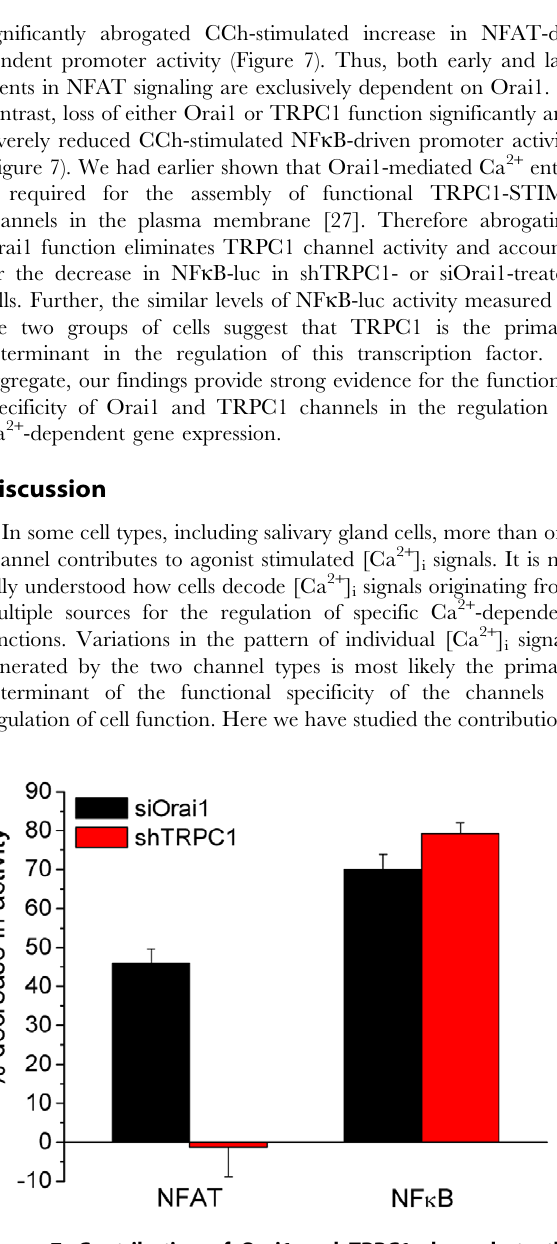
Figure 6. ‘‘All-or-none’’ mode of NFAT activation by Orai1-mediated Ca 2 + entry. [ Ca 2 + ] i responses induced by 300 nM CCh in control cells ( A ), cells expressing STIM1-KK/EE ( B ) or Orai1E106Q ( D ), and cells in Ca 2 + -free media ( C ). Each trace is representative of data obtained from $ 50 cells in at least 3 separate experiments. Insets in A and B show corresponding responses induced by 1 m M CCh over a 10 min time period. ( E ) Average change in the amplitude of [Ca 2 + ] i at t=350 s (F t 2 F 0 ). ( F ) Number of oscillations between the 300 and 600 s time points in control cells, cells expressing STIM1-KK/EE or cells in Ca 2 + -free media following stimulation with 1 m M or 300 nM CCh. ( G ) Panels showing nuclear translocation of NFAT in control cells and cells expressing STIM1-KK/EE, following stimulation with 300 nM CCh with 1 and 10 mM extracellular CaCl 2 . ( H ) Histogram showing the proportion of cells (%) showing nuclear translocation of NFAT following stimulation with 300 nM CCh with 1 and 10 mM extracellular CaCl 2 . Trace shows the [ Ca 2 + ] i responses induced by 300 nM CCh in the presence of 1 and 10 mM extracellular CaCl 2 , and is representative of data obtained from $ 50 cells in at least 3 separate experiments.